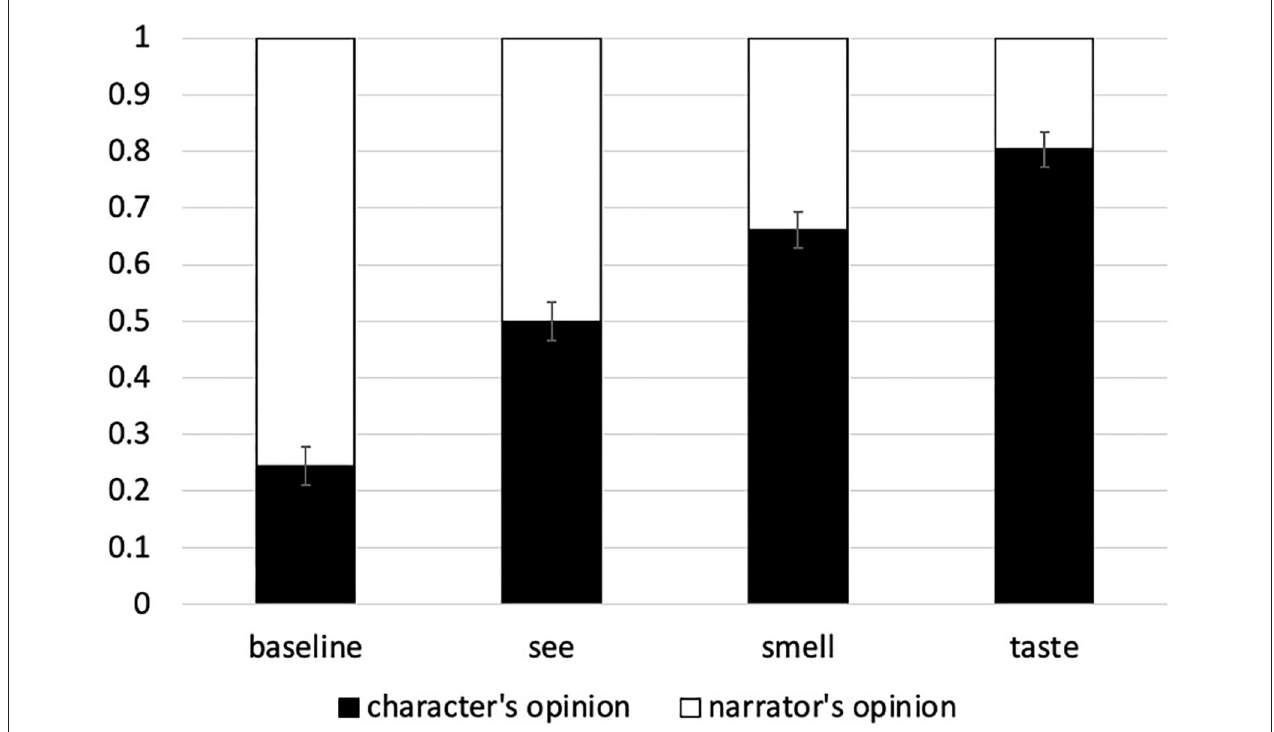
FIGURE 2 | Proportion of character’s opinion and narrator’s opinion answer choices in Experiment